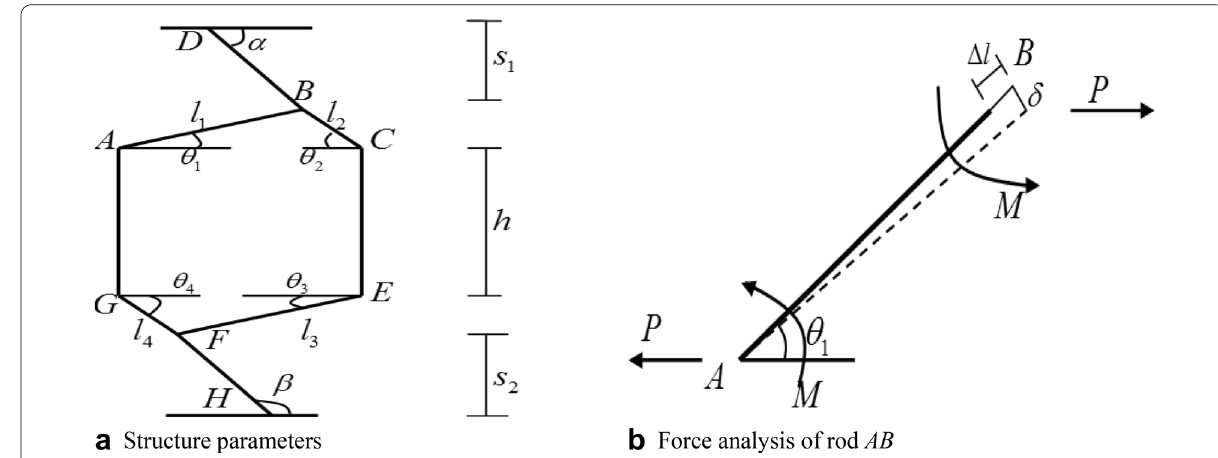
Figure 4 Irregular structure diagram and force analysis of rod AB